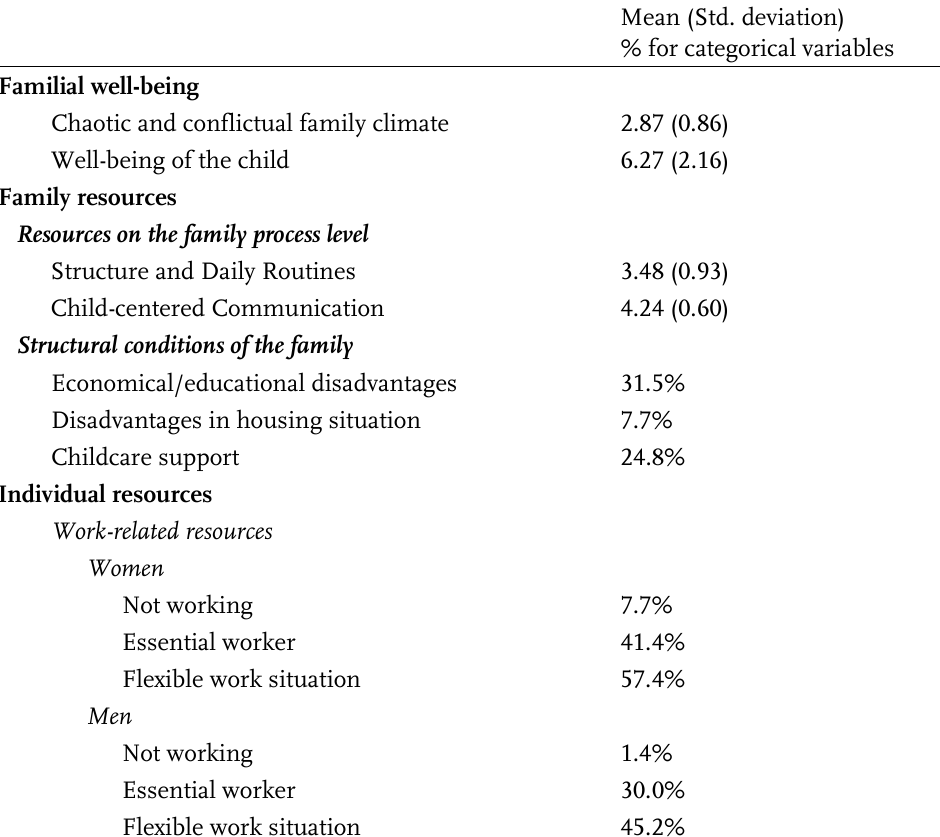
Table 2 : Sample statistics: familial outcomes, family and individual resources